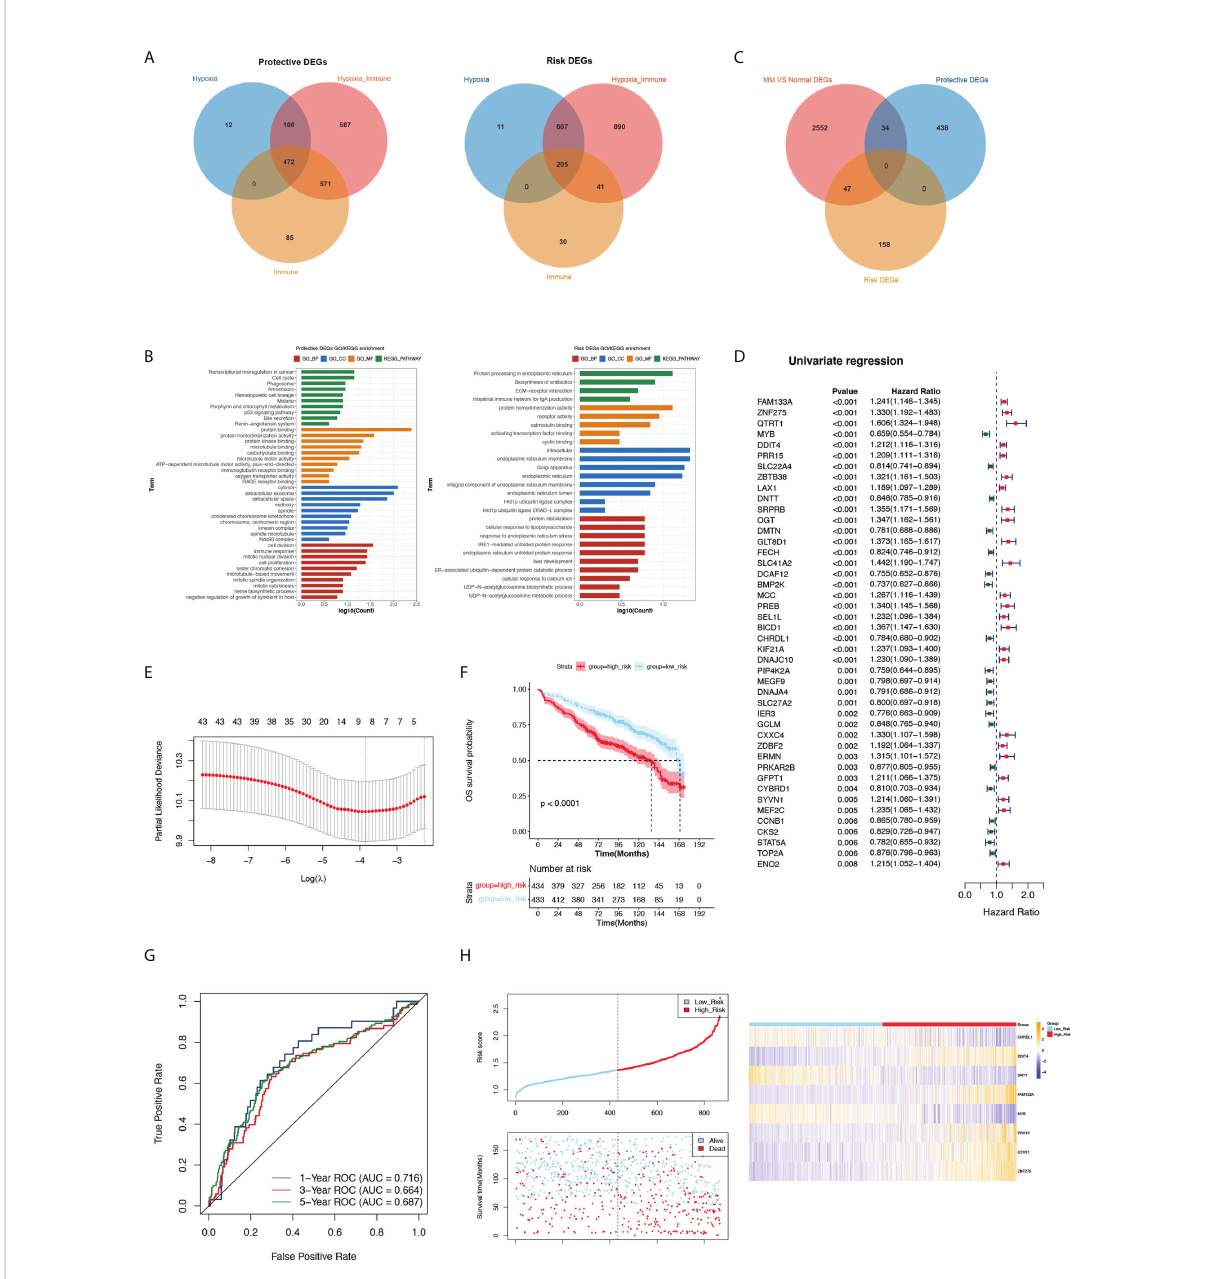
FIGURE 2 Analysis protective and risk genes, construct and assess the prognostic gene signature related to MM. (A) Venn diagram of protective and risk DEGs. (B) GO and KEGG terms enriched in protective and risk DEGs. (C) The Venn diagram among the protective DEGs, risk DEGs and DEGs related to MM. (D) Forest plot of hazard ratios for 44 prognostic DE-H-IRGs. (E) Threefold cross-validation for tuning parameter selection in the LASSO model. (F) K-M analysis between the high- and low-risk groups. (G) ROC curve at 1-, 3- and 5-years of prognostic value of the prognostic index. (H) The distributions of risk score, survival status and expression pro fi le of signature genes between the risk